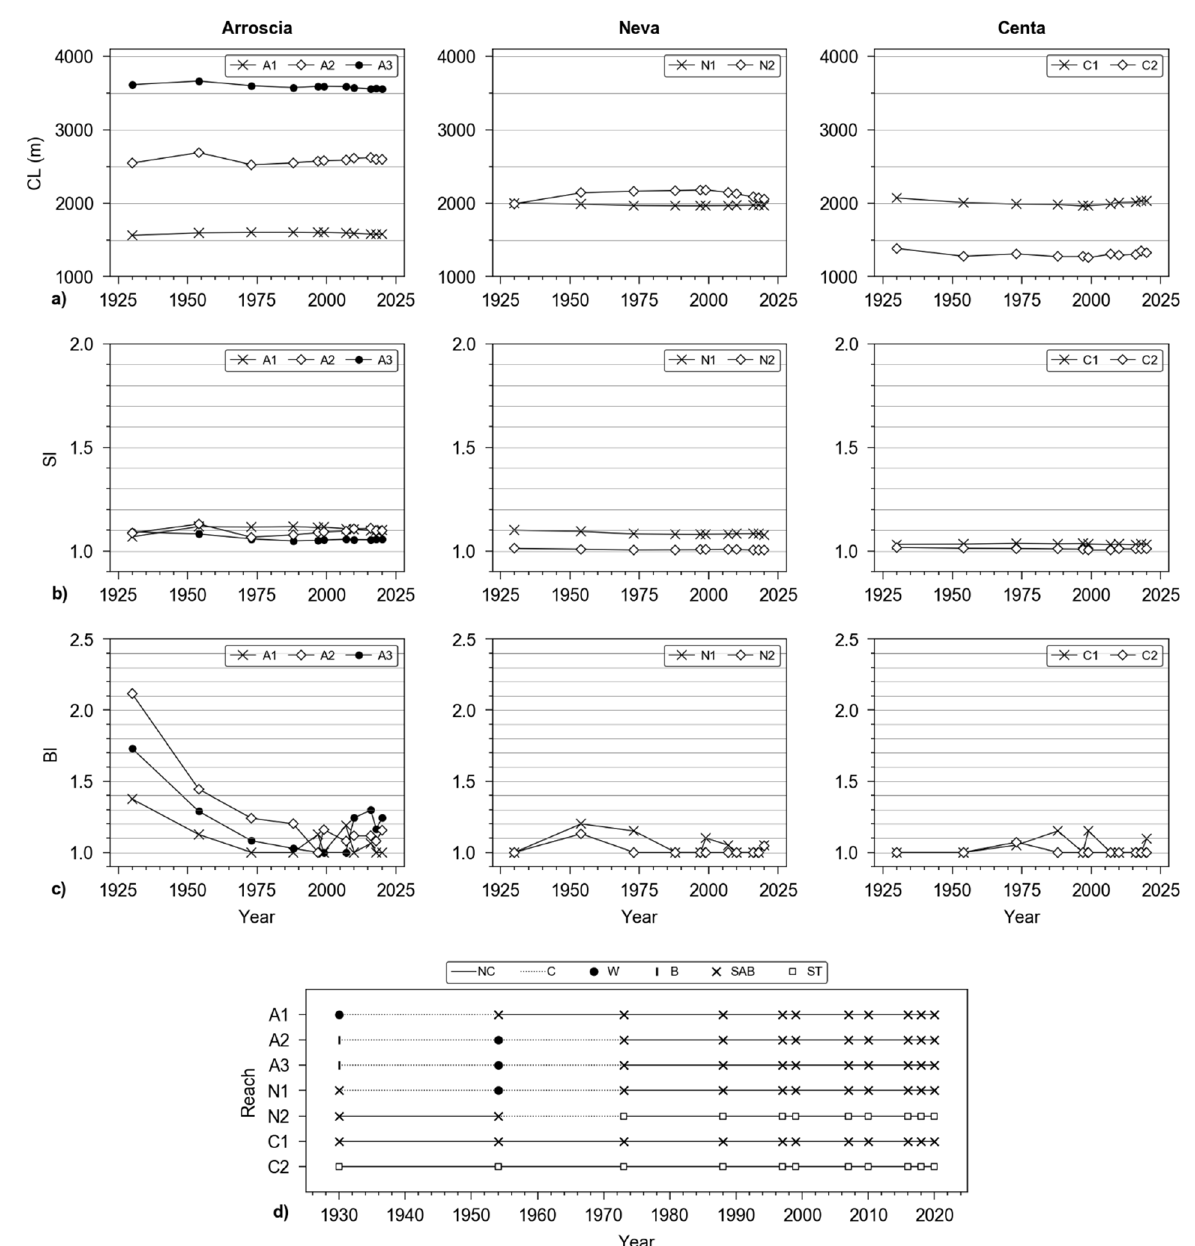
Figure 6. ( a ) Active-channel centerline length (CL), ( b ) sinuosity index (SI), ( c ) braiding index (BI), and ( d ) channel pattern at the reach scale over the period 1930–2020. NC: no change; C: change; W: wandering; B: braided; SAB: sinuous with alternate bars; ST: straight.